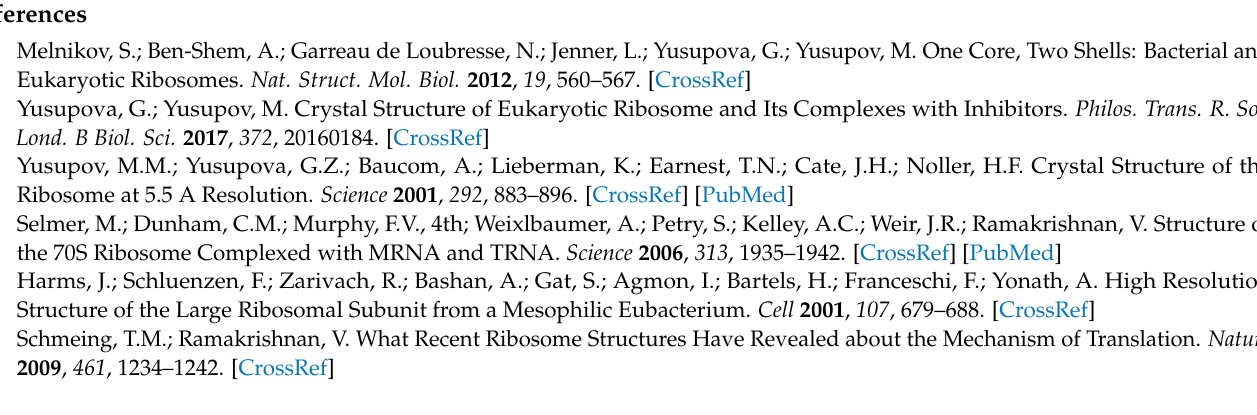
review; Table S1: List of PDB codes for all the compounds discussed in the present